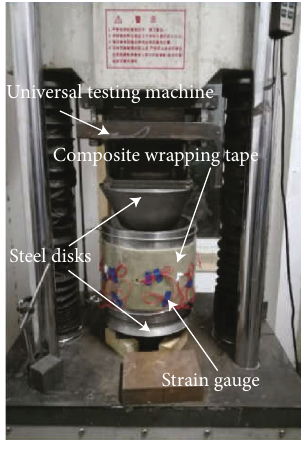
Figure 11: Testing loading